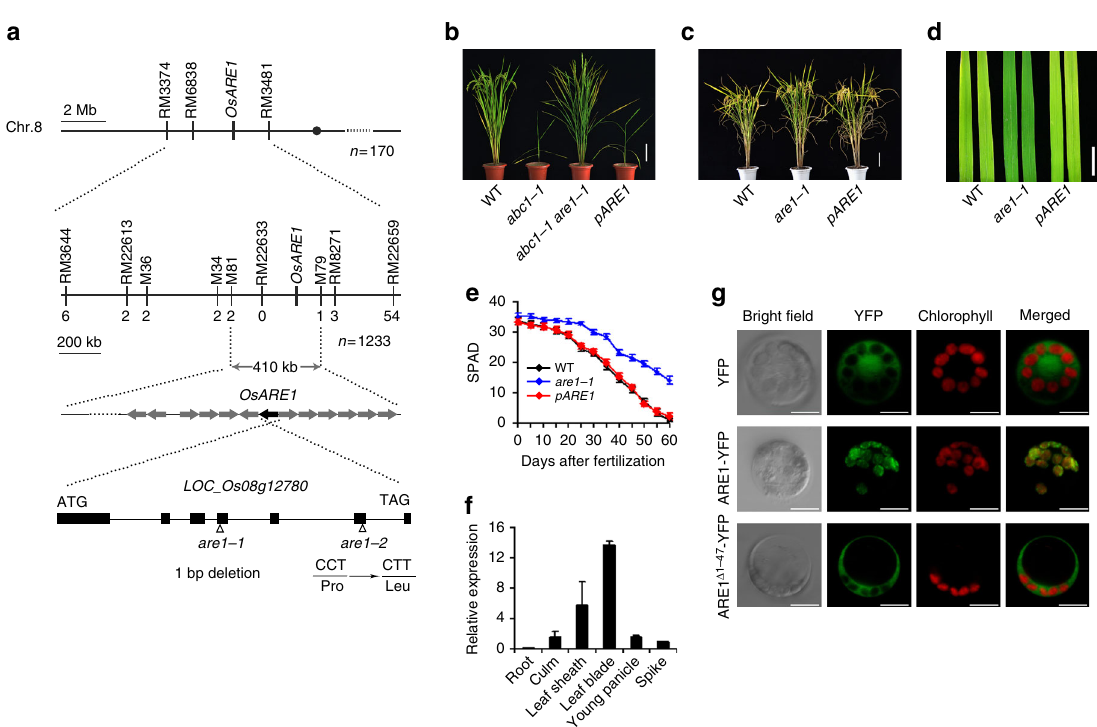
Fig. 3 Molecular characterization of ARE1 . a Genetic mapping of ARE1 . The numbers ( n ) of recombinants used in mapping are given below the genetic maps (see Methods for details). Bottom, a schematic illustration of the ARE1 structure. Filled boxes and lines represent exons and introns, respectively. The mutation natures of are1-1 and are1-2 are shown below. b , c Molecular complementation of the are1-1 mutant phenotype. Plants at the grain- fi lling and dough stages with the indicated genotypes are shown. pARE1 : abc1-1 are1-1 ( b ) and are1-1 ( c ) plants carrying a pARE1::ARE1 transgene, respectively. d Flag leaves derived from plants shown in ( c ). e Analysis of soil-plant analysis development (SPAD) in fl ag leaves of plants with the indicated genotypes at various growth stages. Data presented are mean values with s.d. ( n = 40). f Analysis of the ARE1 expression in various organs by qRT-PCR. Data presented are mean values with s.d. ( n = 3). g Analysis of subcellular localization of ARE1-YFP (yellow fl uorescent protein) protein in rice protoplasts. Scale bars, 15 cm in ( b , c ), 2 cm in ( d ), and 5 μ m in ( g